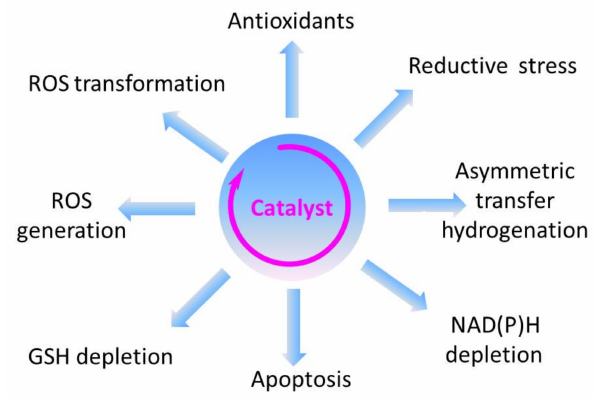
Figure 4. During the last decade, catalysts have been considered for various preventive and/or therapeutic purposes. Whilst natural agents with certain catalytic properties are de facto employed already as nutraceuticals in the field of nutrition or as nutrageceuticals (nutraceuticals employed to maintain or restore health and quality of life during ageing), other small molecule catalysts are still being developed and tested. Here, sensor/effector agents represent a particularly interesting class of agents as they fine-tune existing biochemical signatures. See text for